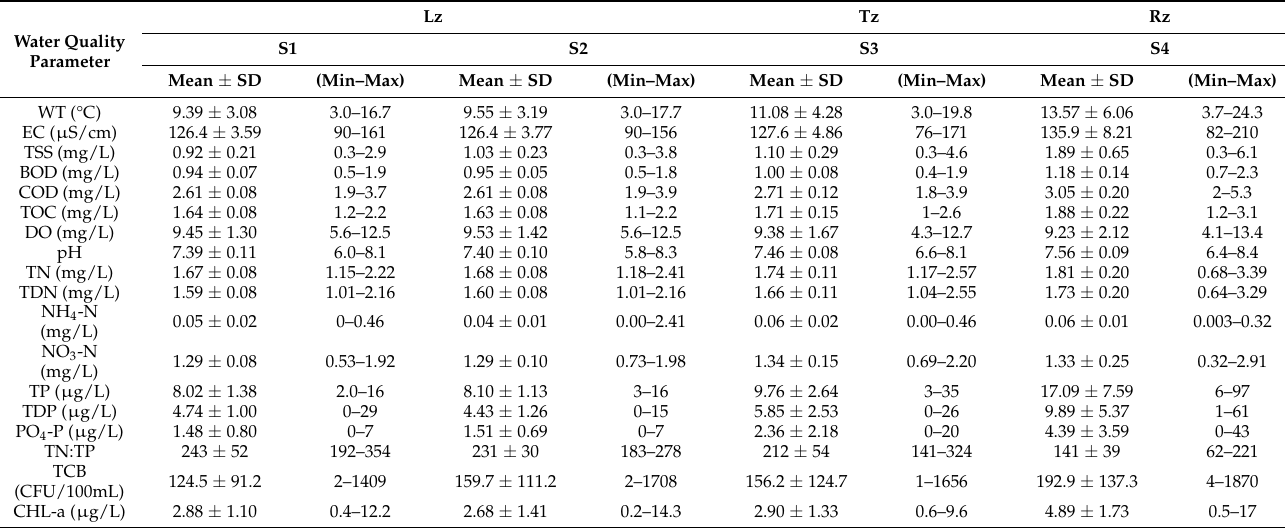
Table 1. The measured water quality parameters at the study sites in Yeongdam Reservoir throughout 2013–2019 (Lz– lacustrine zone, Tz–transition zone, Rz–riverine zone).